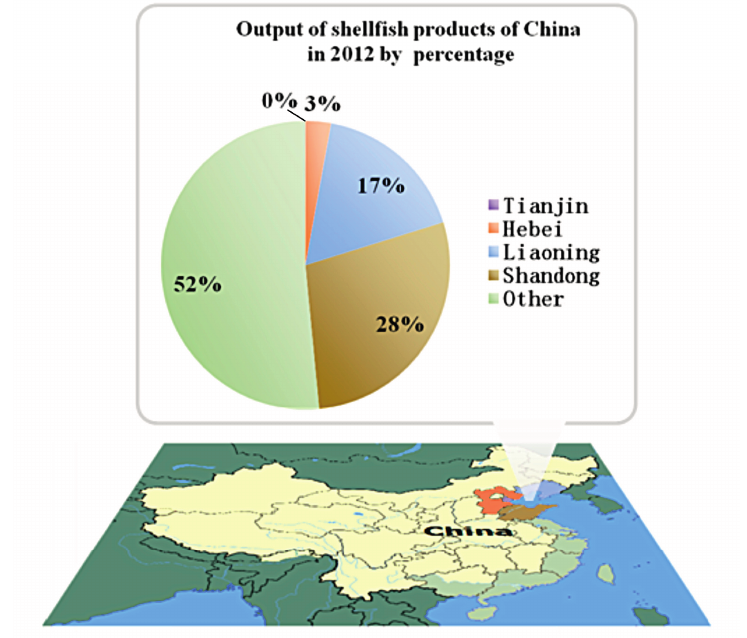
Figure A5. Output of shellfish products of China in 2012 by percentage. Source: China Statistical Yearbook 2013